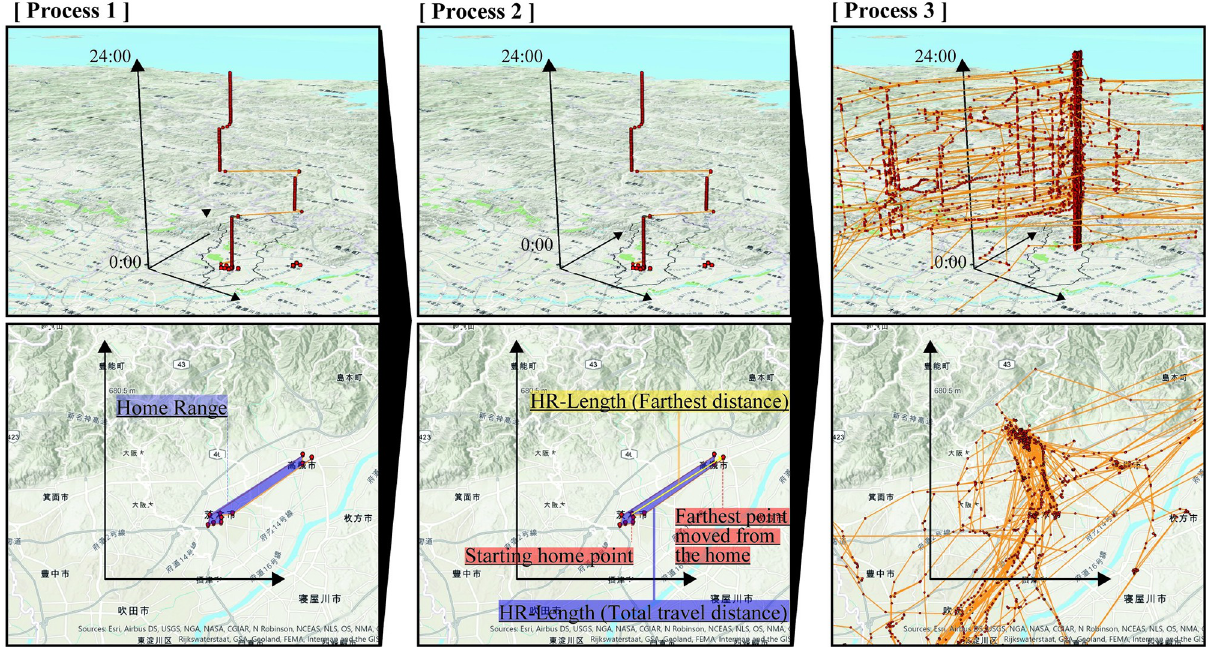
Fig 2. Analysis process to analyze the home range. The upper figure is a 3D spatiotemporal map, and the lower figure is 2D. In process 1, the personal space-time paths between 0:00 to 23:59 h were drawn. In process 2, the home range distance for each mobile phone user is calculated from the latitude and longitude difference between the starting home point and the farthest point moved from the home after 0:00 h. The home was estimated by the starting home point after 0:00. In process 3, the distance of the mobile phone user is averaged to calculate the HR-length (Farthest Distance) and HR- length (Total Travel Distance) of every day. The space-time paths are the imaginary paths of 50 people.